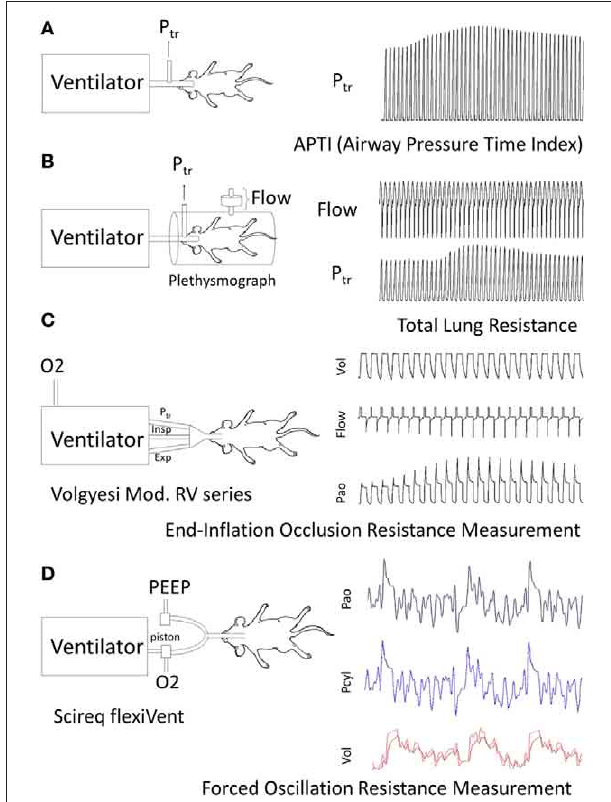
FIGURE 1 | Examples of routine methods of Respiratory mechanics Measurements for AHR: each panel illustrates animal instrumentation, airway measurement (s) and presence of mechanical or spontaneous ventilation. (A) Airway Pressure Time Index : APTI measures the tracheal pressure response to MCh in a mouse to calculate an aggregate change in respiratory system impedance (Levitt and Mitzner, 1988). (B) Flow Plethysmography : Flow and tracheal pressure (P tr ) signals derived from a flow-plethysmograph and tracheal cannula are used to calculate Rrs or RL depending on whether transrespiratory or transpulmonary pressure is measured (Amdur and Mead, 1958; Waldron and Fisher, 1988). (C) End-Inflation Occlusion : This technique relies on a purpose built ventilator to deliver and hold known inflation volumes and measure the resultant pressure peak and plateau pressures to calculate Rrs and Crs (Ewart et al., 1995; Volgyesi et al., 2000). Ventilators may be lab constructed or use a commercial product (Volgeysi ventilator). (D) Forced Oscillation Technique : The FOT method relies on a purpose built ventilator requiring sophisticated software for the control of volume perturbations and analysis of generated pressure, volume and flow signals. In brief, ventilator housed pistons generate a complex frequency perturbation in the volume signal administered to mice. The lung response is measured as pressure from which lung impedance and other variables are calculated. Current use applications in the literature appear to be restricted to a commercially built ventilator